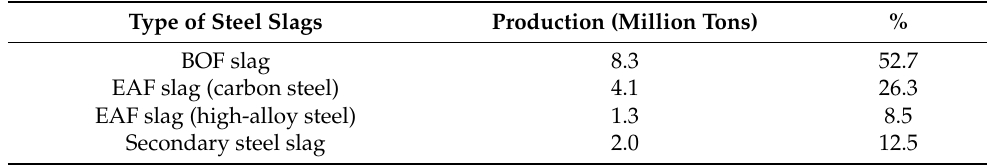
Table 1. Steel slag production in Europe, year 2018